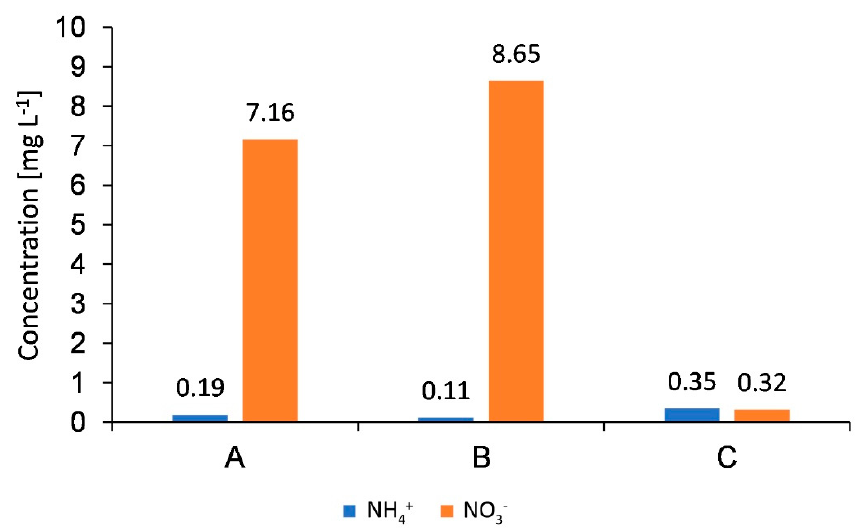
Figure 14. Concentrations of ammonium and nitrate ions in groundwater at the analyzed experimental sites: A, B, C [80,81].